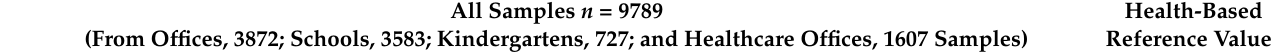
Table 2. Statistics of the most frequent VOCs ( a ), formaldehyde ( b ), and selected infrequent VOCs ( c ), in air samples collected from Finnish office and similar non-industrial indoor environments in 2010–2019. Health-based reference values (RW I, RW II, and EU-LCI) are presented for comparison if available. LOQ values of different groups of compounds are